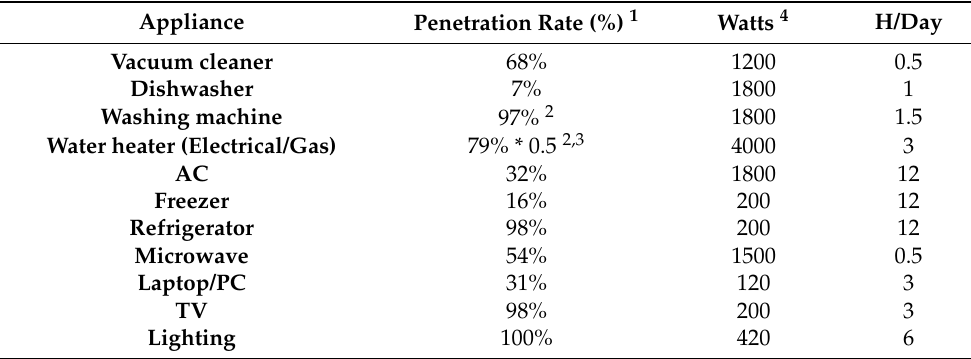
Table 9. Power consumption and penetration rates of different electrical appliances in Jordan’s residen- tial sector.